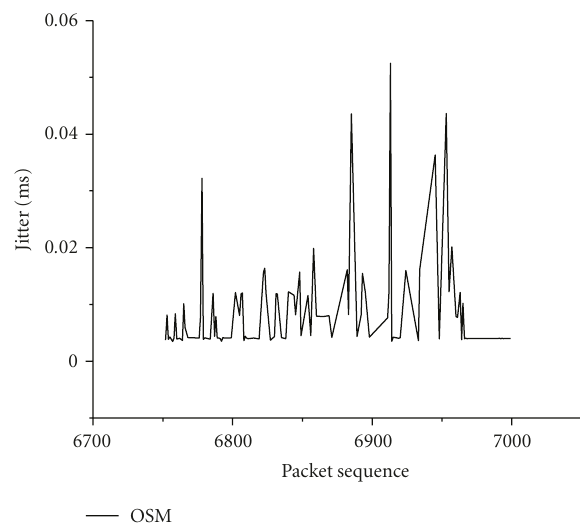
Figure 9: Jitter in OSM with error model.